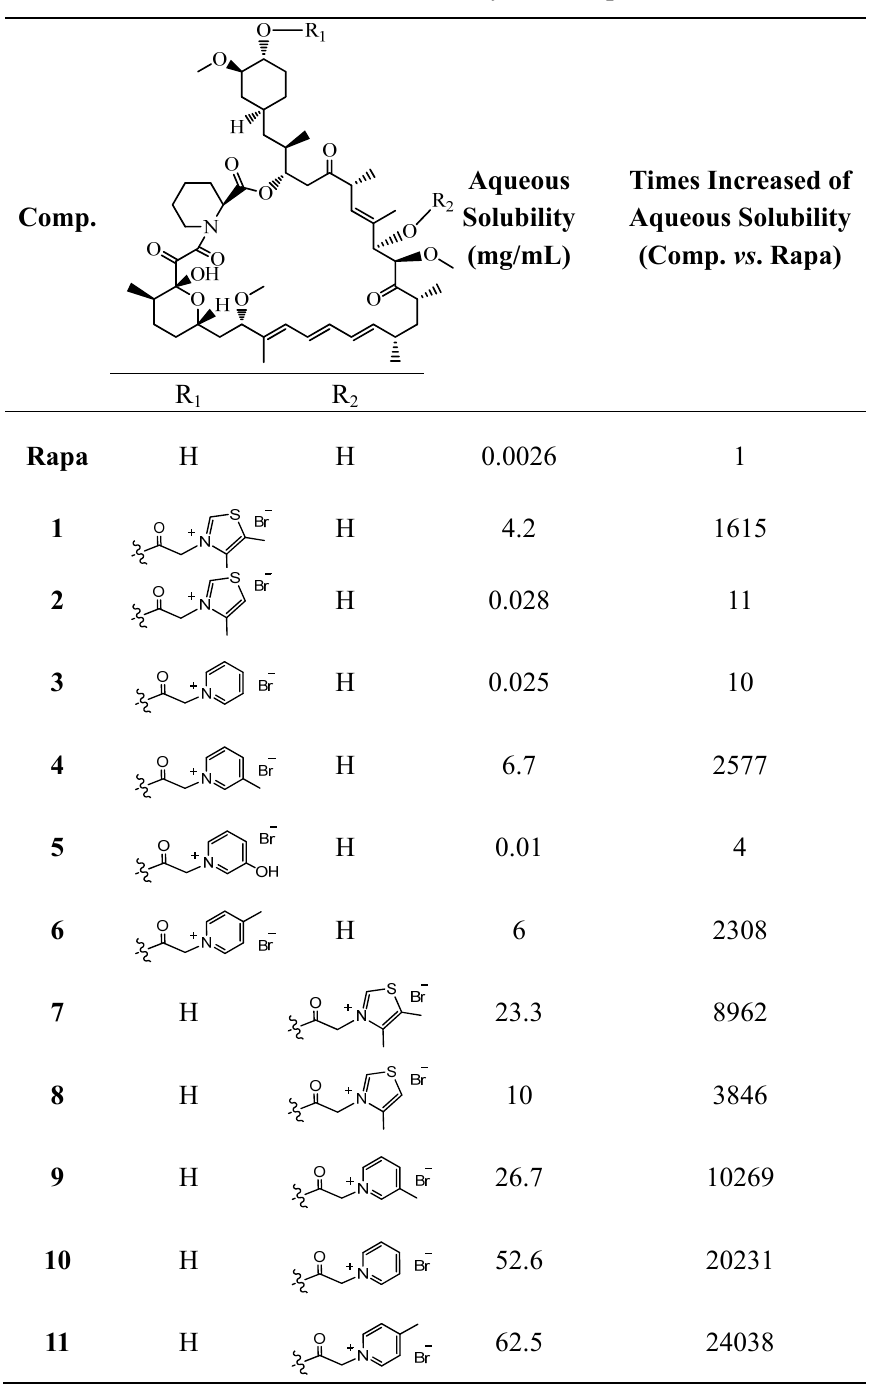
Table 1. Structures and solubility for compounds 1 – 11